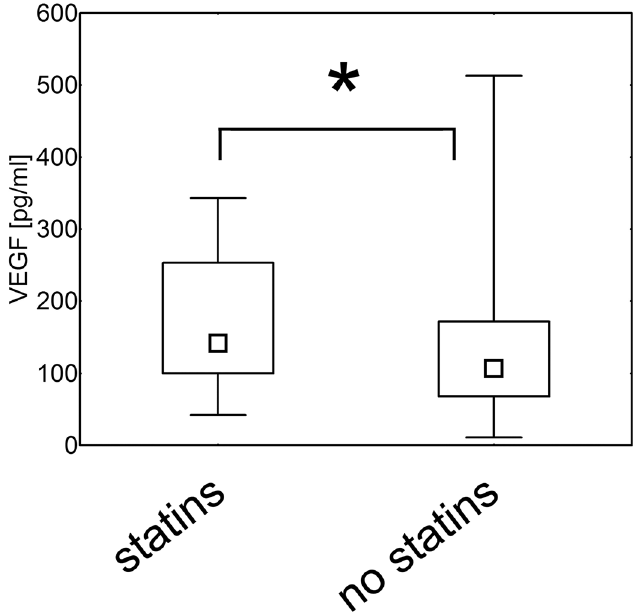
Fig 7. Statin treatment and serum levels of VEGF. Healthy and hypertensive individuals treated with statins had increased serum levels of VEGF when compared with not treated subjects (Mann- Whitney U test; p = 0.04). The data are presented as medians (symbols inside the boxes), 25 – 75% percentiles (boundaries of the boxes) and minimum-maximum (error bars outside the boxes). Statistical significance (p < 0.05) is marked with “ * ”